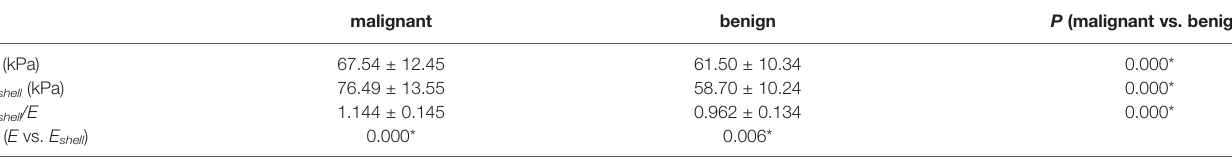
TABLE 2 | Average E , E shell and E shell /E ratio of malignant and benign